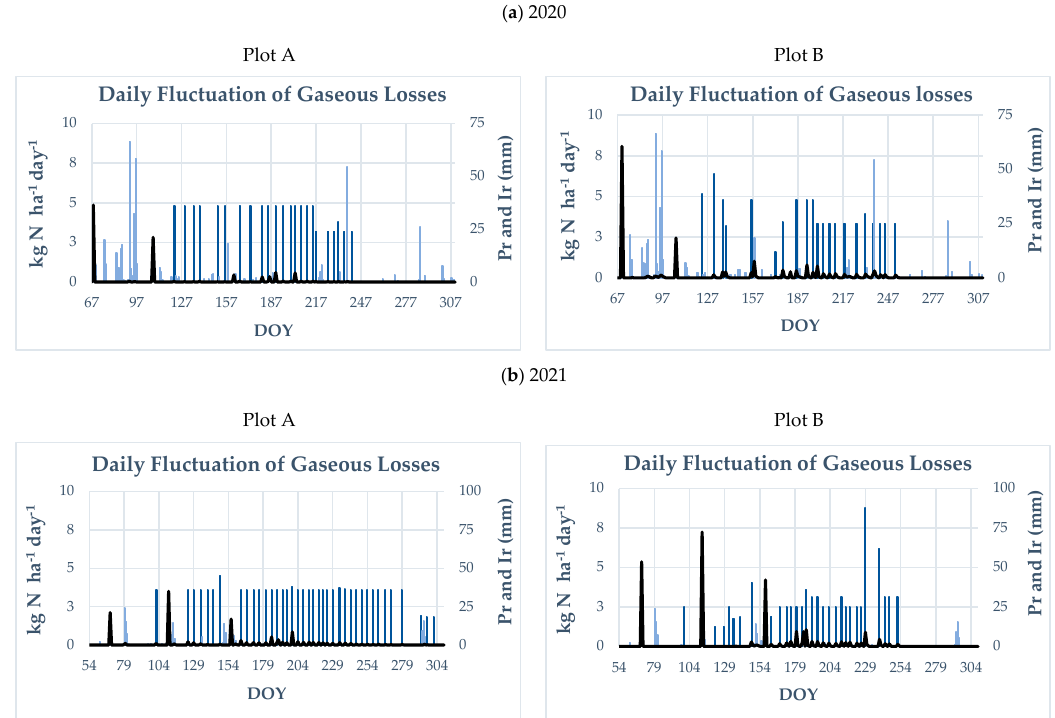
Figure 7. Daily fl uctuation of gaseous losses in kg N ha − 1 day − 1 , for plots A and B in ( a ) 2020 and ( b ) 2021; simulated by the CropSyst model. The blue bars show precipitation (Pr), whereas the dark blue bars show irrigation (Ir) water applied.